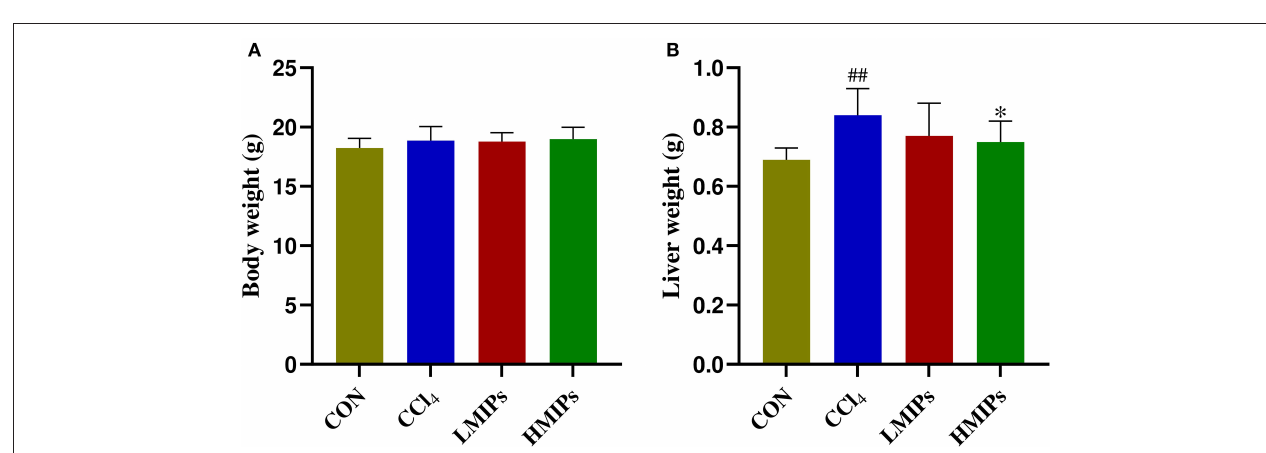
FIGURE 2 | Effects of MIP infusion on the body (A) and liver weight (B) . The values are reported as the mean ± SD of six mice per group: (##) P < 0.01 compared with the control group and (*) P < 0.05 compared with the carbon tetrachloride (CCl 4 )-treated group.